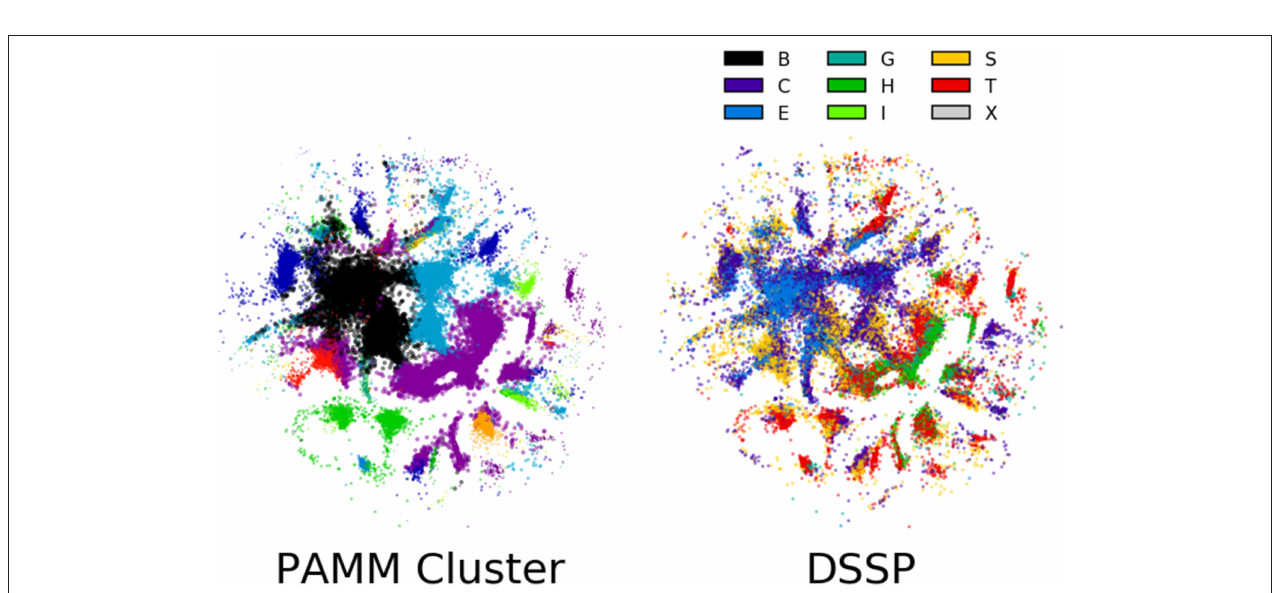
FIGURE 6 | Joint and conditional probabilities for the secondary structures obtained from DSSP and the clustering of dihedral angles from PAMM, where A is the cluster assignment and y the secondary structure classification.